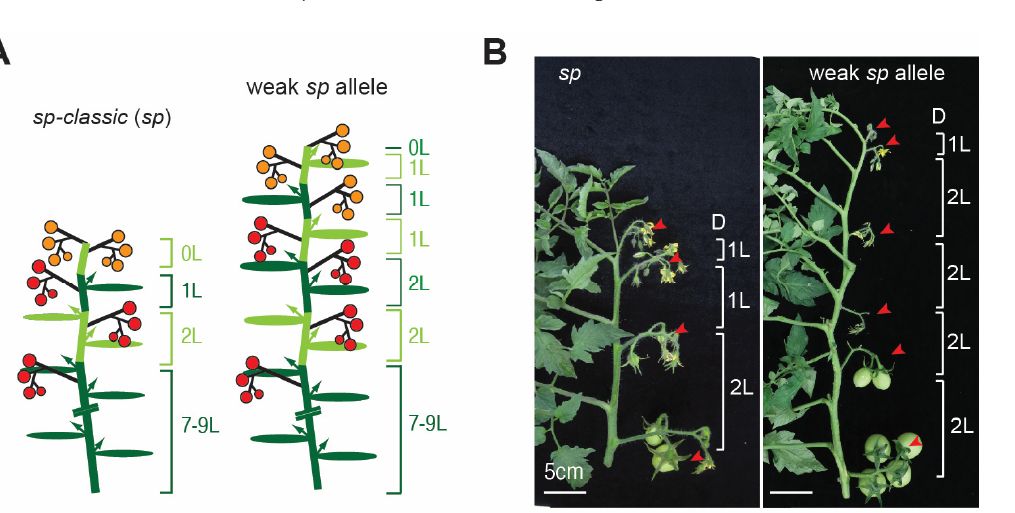
Figure 1. Tomato plant architecture of sp-classic and hypothetical weak sp allele. ( A ) Diagrams depicting tomato plant architecture of sp-classic and hypothetical weak sp allele. The dark green bars and ovals represent the primary shoot and associated leaves in the main shoot. Alternating white green and dark green bars and ovals indicate successive sympodial shoots. Arrows indicate axillary shoots and black lines indicate inflorescences. Red- and orange-colored circles represent maturing fruits. ( B ) Representative main shoots from sp-classic and hypothetical weak sp allele. Three-month-old plants are shown. Arrowheads indicate inflorescences. L, leaf. Scale bars, 5 cm.